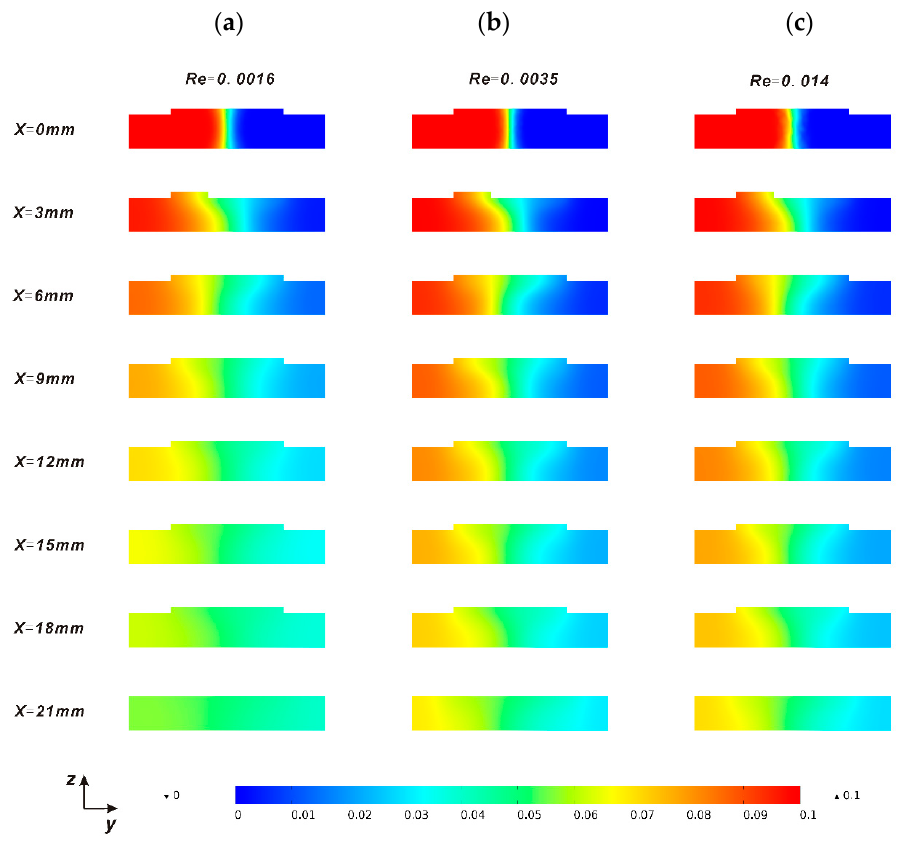
Figure 4. The concentration profiles along the main channel for various Re , ( a ) ( Re = 0.0016); ( b ) ( Re = 0.0035); ( c ) ( Re = 0.014). The uniformity of the color represents the mixing performance.